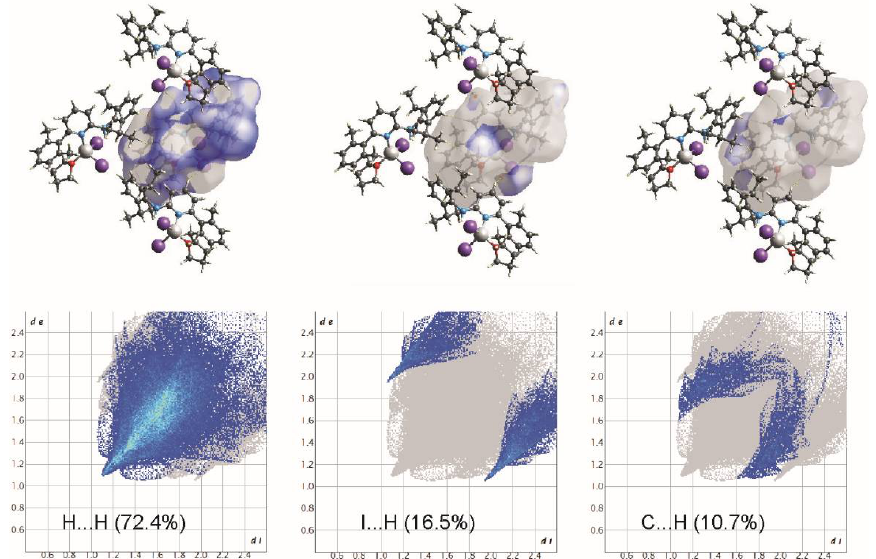
Figure 6. View of the three-dimensional Hirshfeld surface of 2 plotted over d norm in the range −0.0888 to 1.3946.